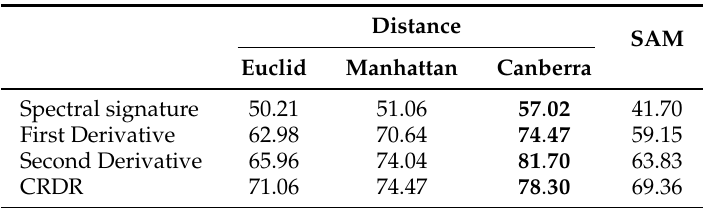
Table 8. Overall accuracy (%) for different distances on [350–2500 nm] considering Median reflectances as spectral reference